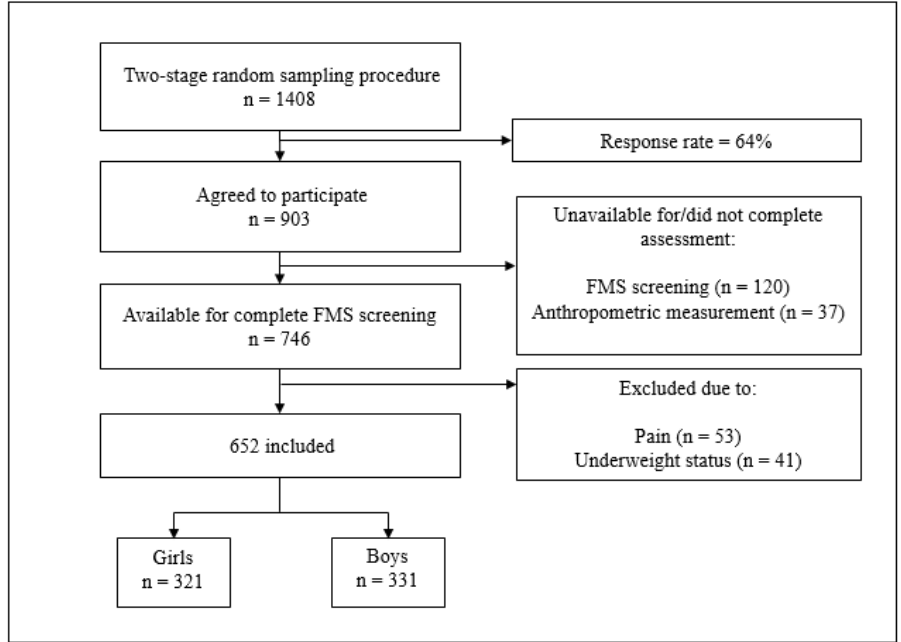
Figure 1. Flowchart of included participants. Note: FMS screening = functional movement screening standardized procedure.